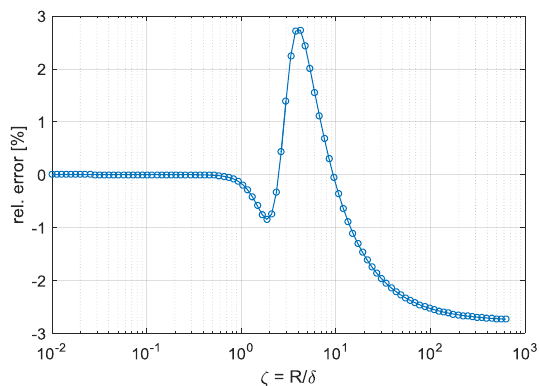
Fig. 3 the improvement of function (38) over (36) becomes apparent.